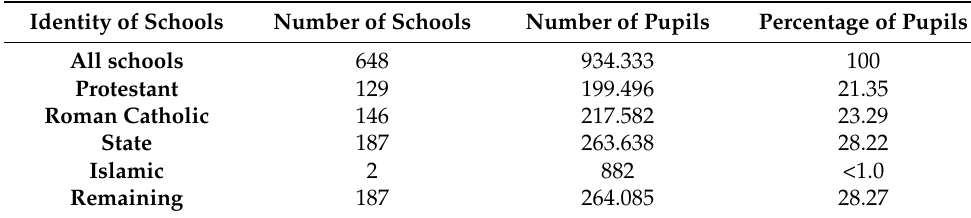
Table 2. Schools and pupils according to secondary school